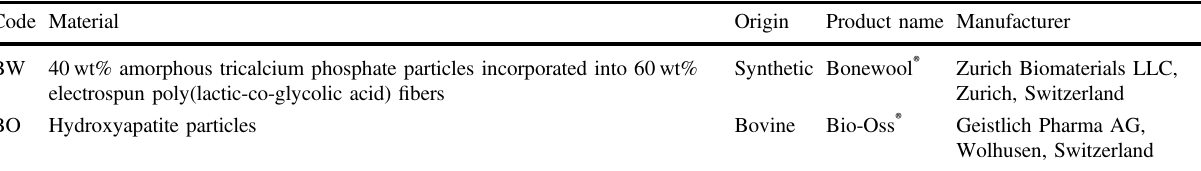
Table 1 Bone graft materials tested in the present study Code